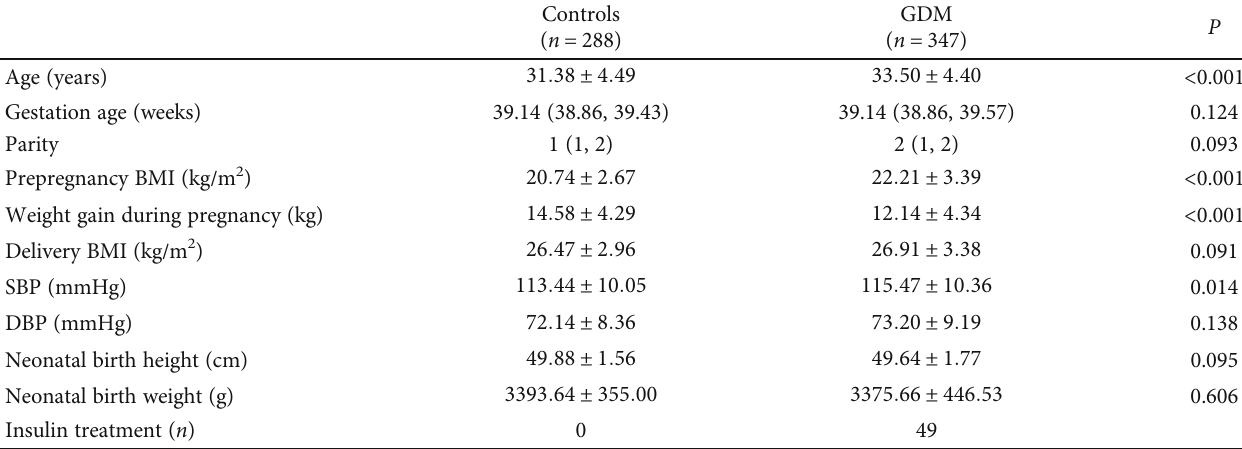
Table 1: Clinical characteristics of the women with GDM and the women with uncomplicated